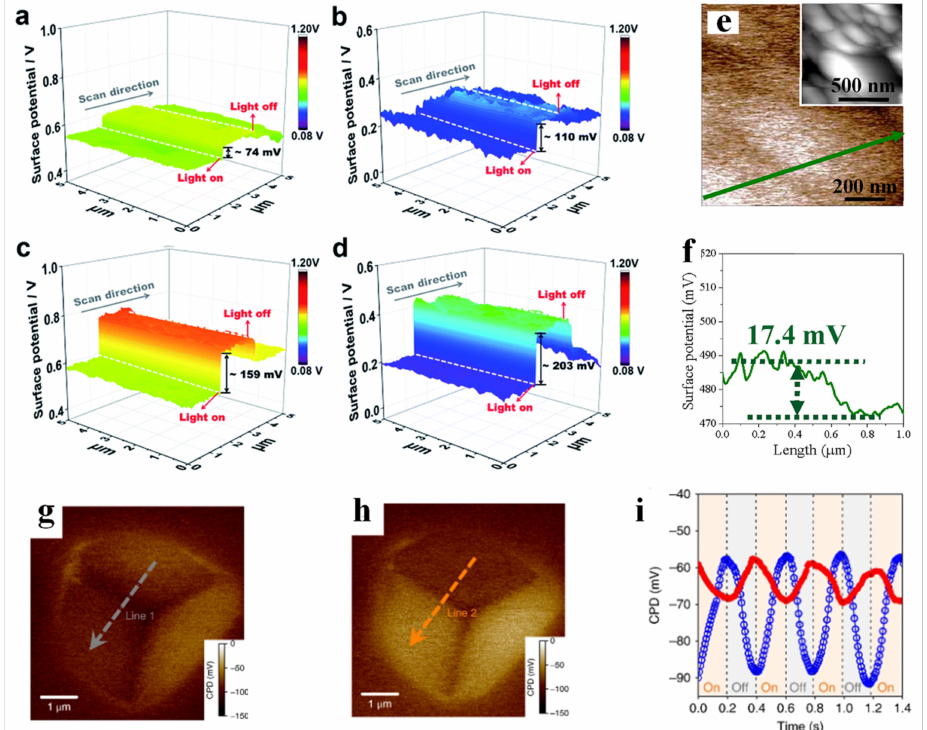
Figure 3. Surface potential of pure BiVO 4 ( a ), BiVO 4 /AgO x ( b ), BiVO 4 /NiO x ( c ), and BiVO 4 /AgO x /NiO x ( d ) photoanodes. Adapted with permission from ref. [82]. Copyright 2018 The Royal Society of Chemistry. The KPFM and surface potential results ( e , f ) for NiCoO 2 /BV; the insert figure is the morphology of sample. Adapted with permission from ref. [17]. Copyright 2019 Elsevier. Corresponding surface potential images in the dark state ( g ) and under illumination ( h ) ( λ = 450nm). Transient surface potential signals on the illuminated facet (blue) and shadow facet (red) collected with 5 Hz modulated light ( i ). Adapted with permission from ref. [84]. Copyright 2018 Springer